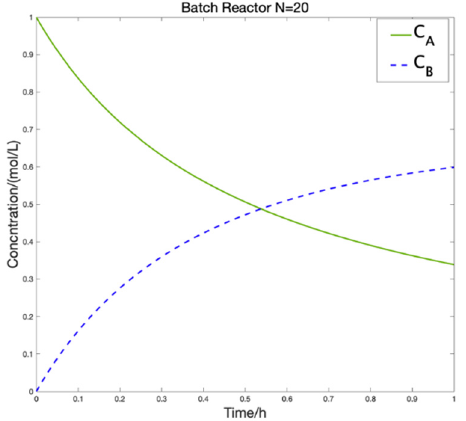
Figure 25. Optimal trajectory of state variables ( N = 20). Table 6. Comparison of methods of batch reactor ( 20 N = ).